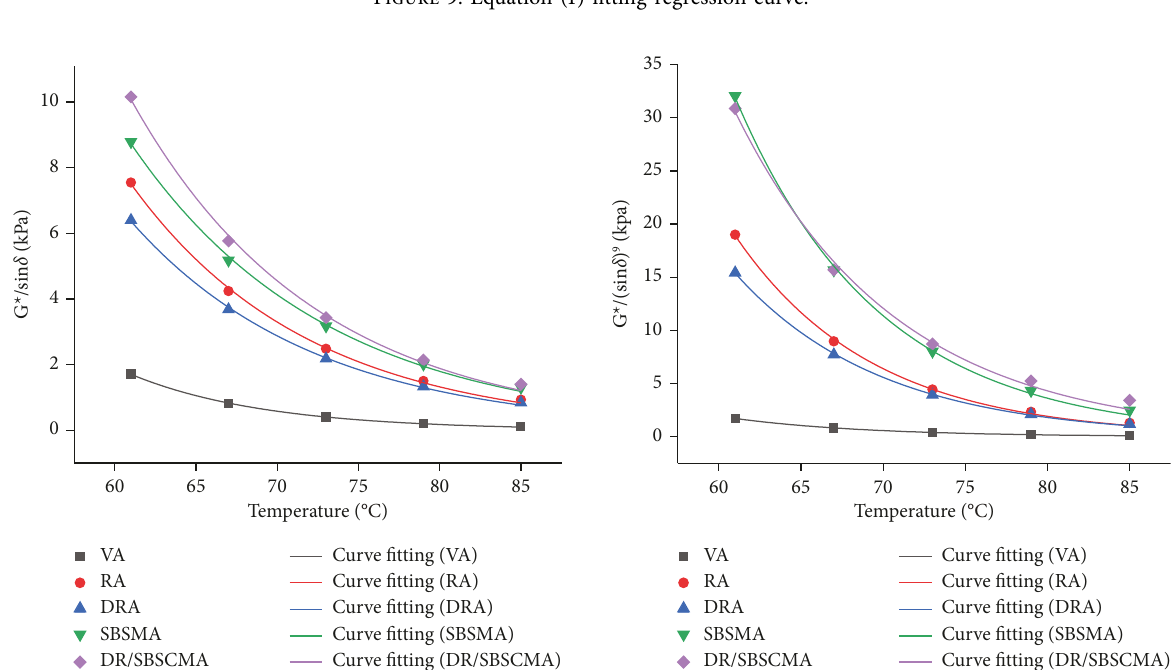
Figure 10: Equation (2) fitting regression